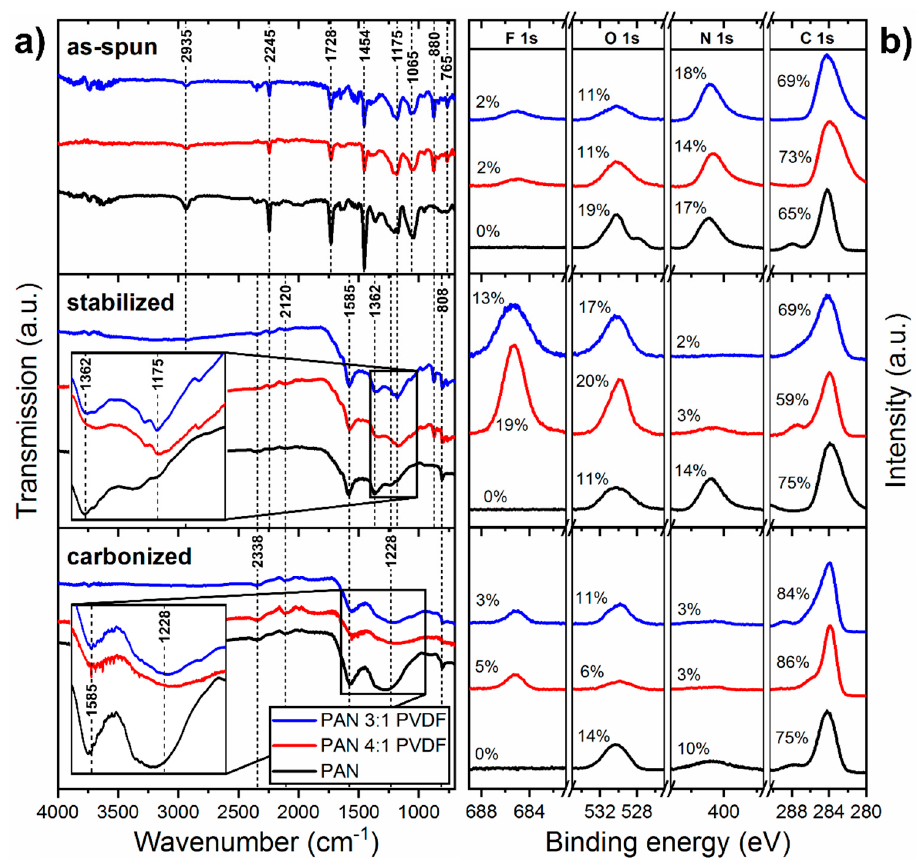
Figure7. ( a )ATR-FTIRand( b )XPSspectraofas-spun, stabilizedandcarbonizednanofibers. Figure 7. ( a ) ATR-FTIR and ( b ) XPS spectra of as-spun, stabilized and carbonized nanofibers. XPS spectra show F 1s, O 1s, N 1s and C 1s signals separately with calculated relative atomic ratios.